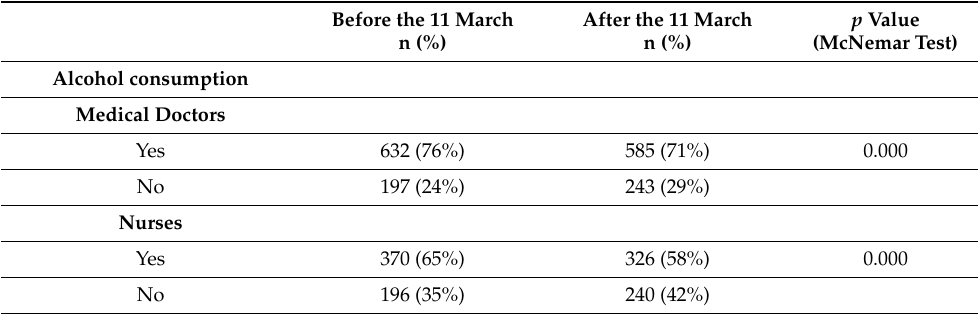
Table 3. Behaviours before and during the first wave (post 11